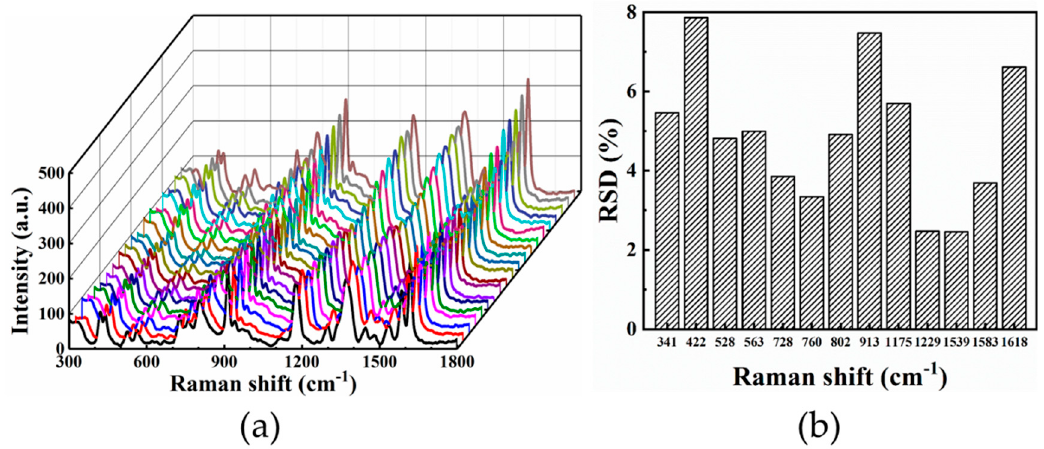
Figure 6. ( a ) SERS spectra of CV with the concentration of 10 − 10 mol / L absorbed on hierarchical LIPSS collected from 20 locations from the substrate; ( b ) RSD(relative standard deviation) value of the major Raman peaks of CV spectrum.